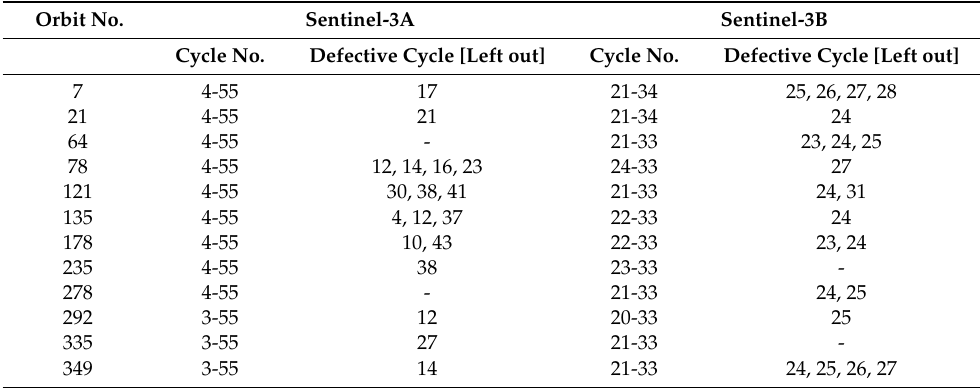
Table 2. The OLCI imagery used in the present investigation. The “left-out” cycles refer to cycles where none of the ten pixels contains IWV valid measurements (Cloudy) for the GNSS stations.